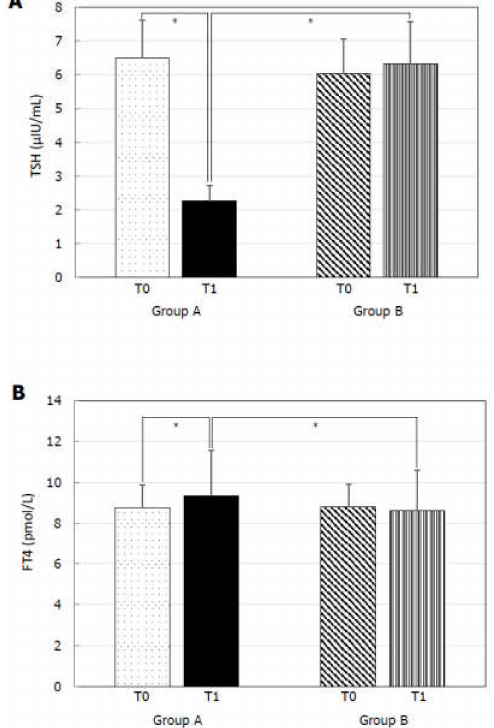
Figure 1. Thyroid-stimulating hormone (TSH) and free-thyroxine (FT4) before (T0) and six months after levo-thyroxine (LT4) or administration or no treatment (T1). Serum TSH levels ( A ) significantly decreased and serum FT4 ( B ) significantly increased after six months of LT4 administration at the dose of 1 µ g / kg / day in Group A. * p <